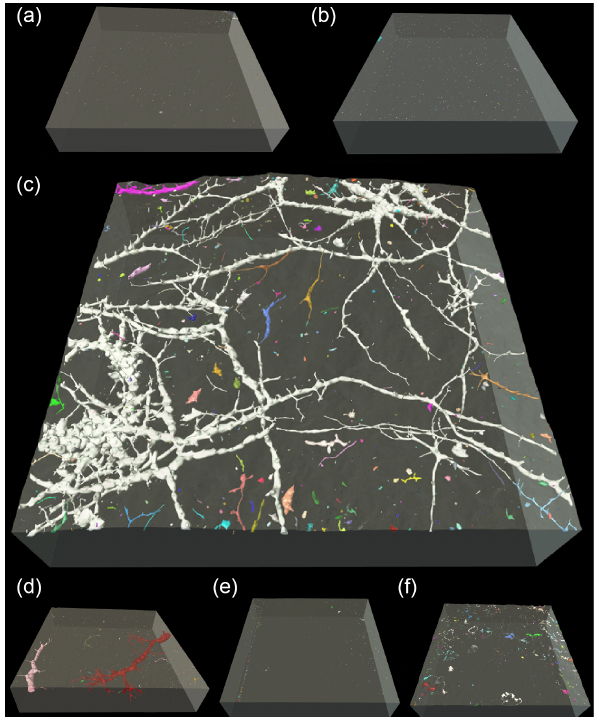
Figure 2. Micro-computed tomographic visualisation of bioerosion traces in experimental blocks deployed for 1–4 years. (a–b) The 1-year blocks showed no macrobioerosion traces. First bioerosion traces were observed (c) in the 2-year block with Entobia cateni- formis and (d) in the 3-year block with E. megastoma . (e–f) The 4-year blocks showed no distinct macrobioerosion traces (size of blocks = 90 × 90 ×